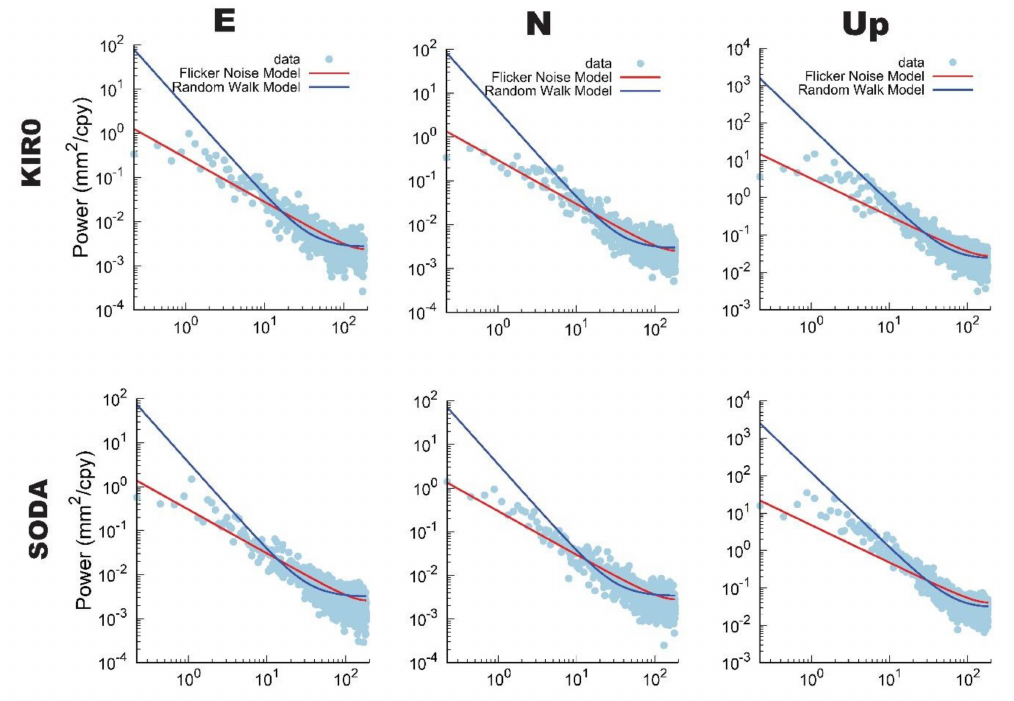
Figure 3. Stations with flicker and random walk noise mode for the Up component.